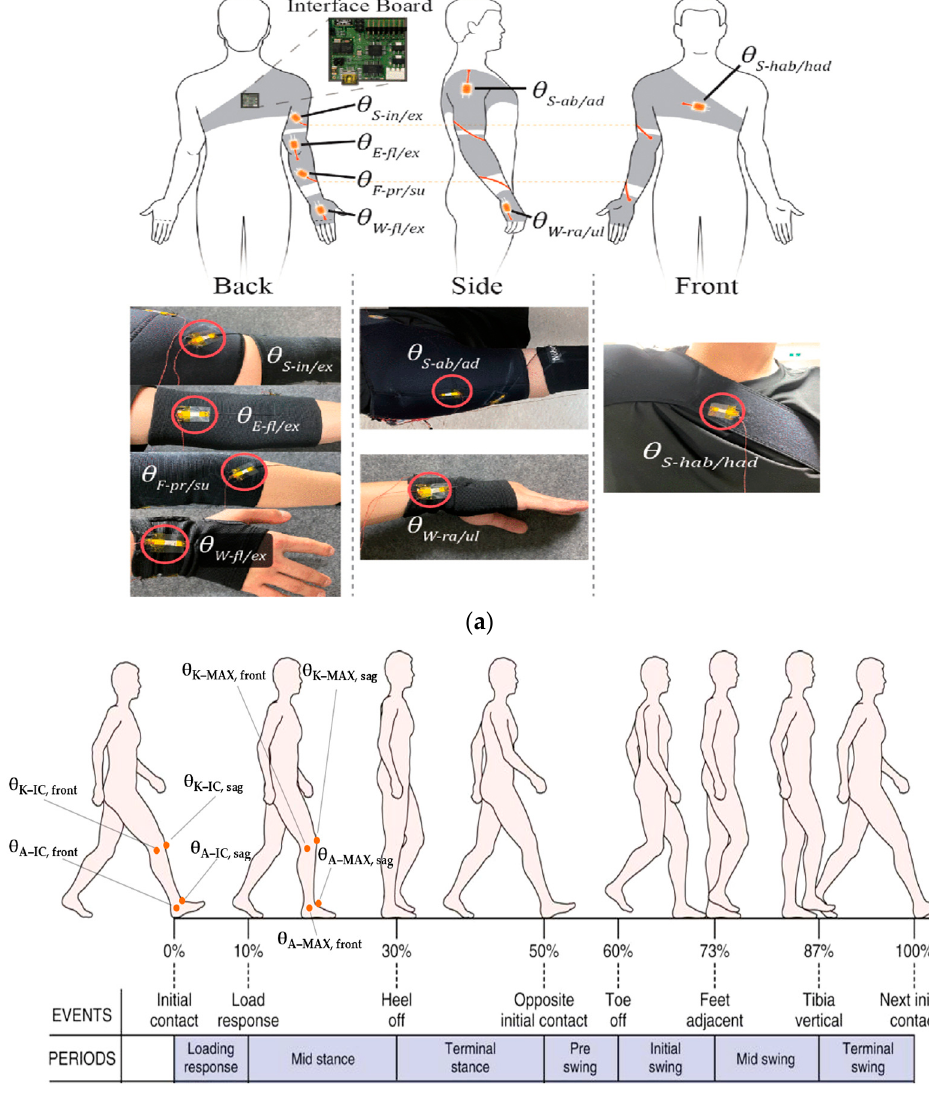
Figure 4. Schematic illustration of a subject wearing tendon-inspired motion detection devices and pictures of the integrated device into wearable belts ( a ) [24]. The main angles measured on the lower limbs for rehabilitation monitoring and sports tracking are highlighted in ( b ).